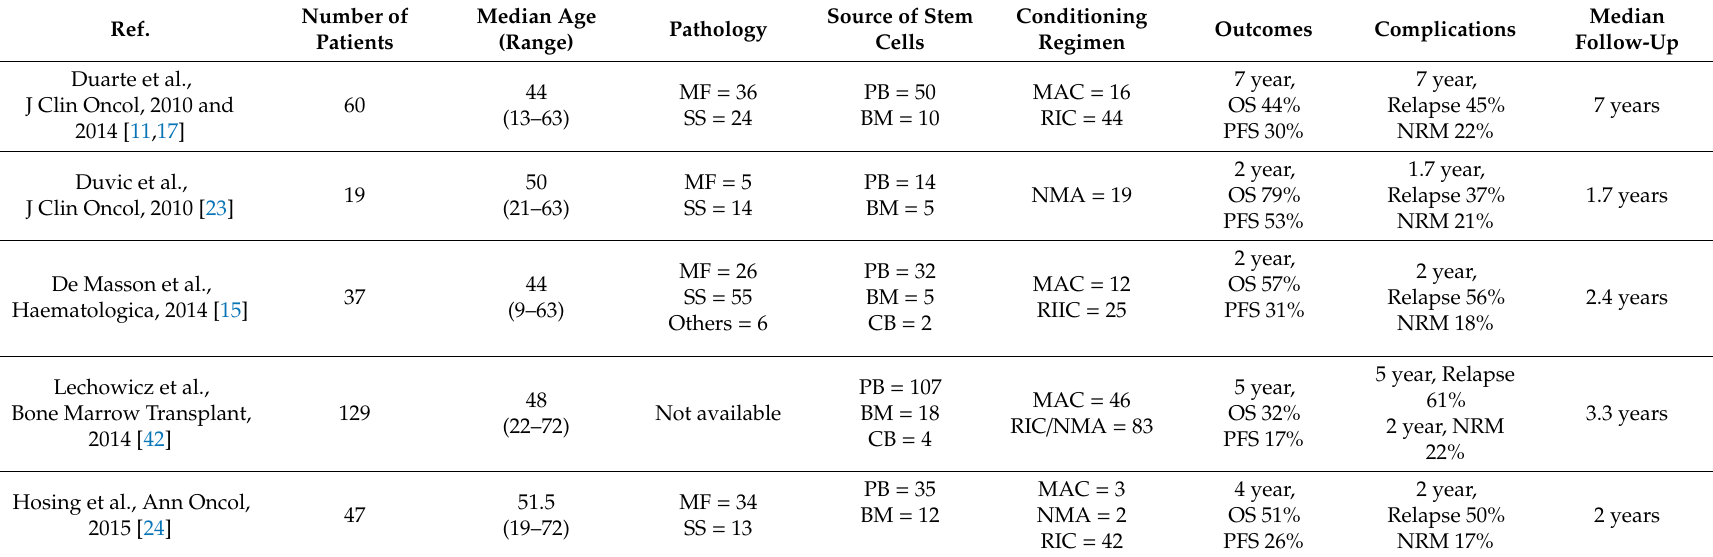
Table 1. Main studies on patients with cutaneous T-cell lymphomas treated with allogeneic stem cell